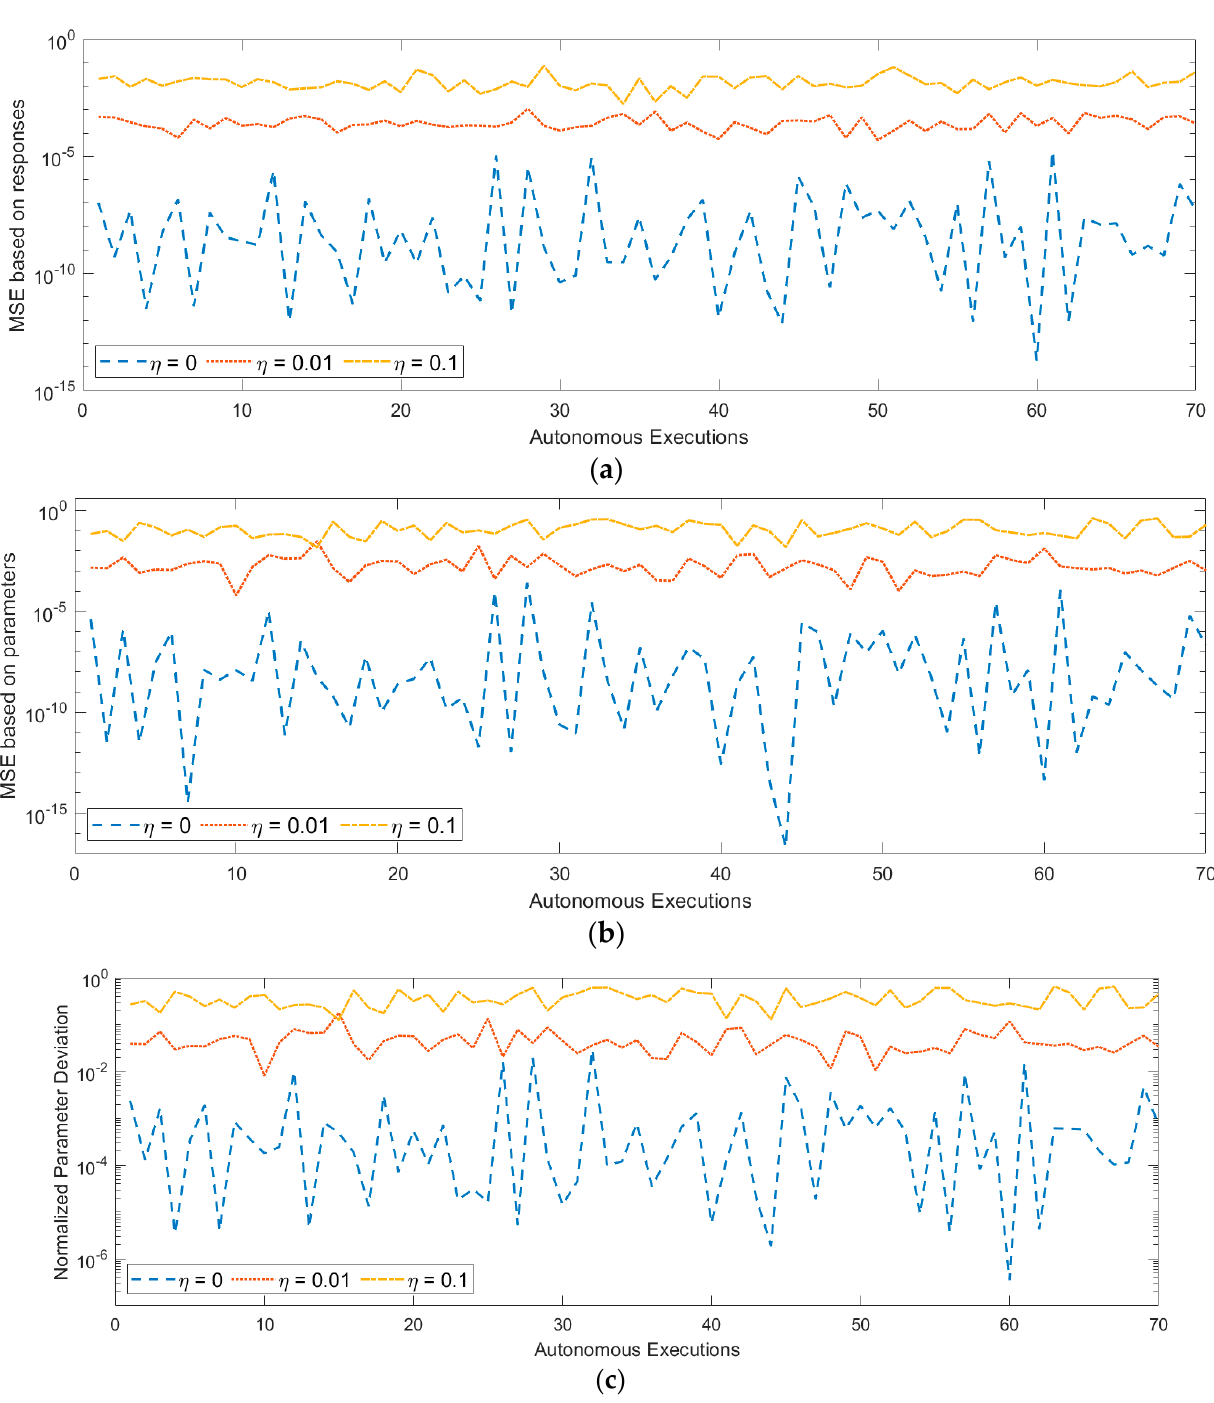
Figure 6. Results of autonomous executions through different evaluation metrics for Problem 1. ( a ) MSE through estimated response ( b ) MSE through estimated parameters ( c ) Normalized parame- ter deviation